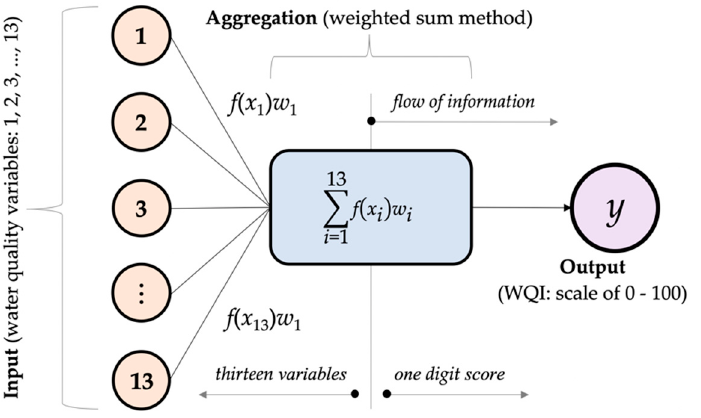
Figure 1. Design diagram indicating the framework and concept considered for the establishment of the universal water quality index (UWQI) model. A model framework showing the thirteen water quality input variables x 1 , x 2 , x 3 , ... , x 13 , their corresponding weights, w 1 to w 13 , sub-index functions, f ( x 1 ) to f ( x 13 ), and the aggregation function f ( x i ) w i applied to calculate the weighted influence of the input variables.